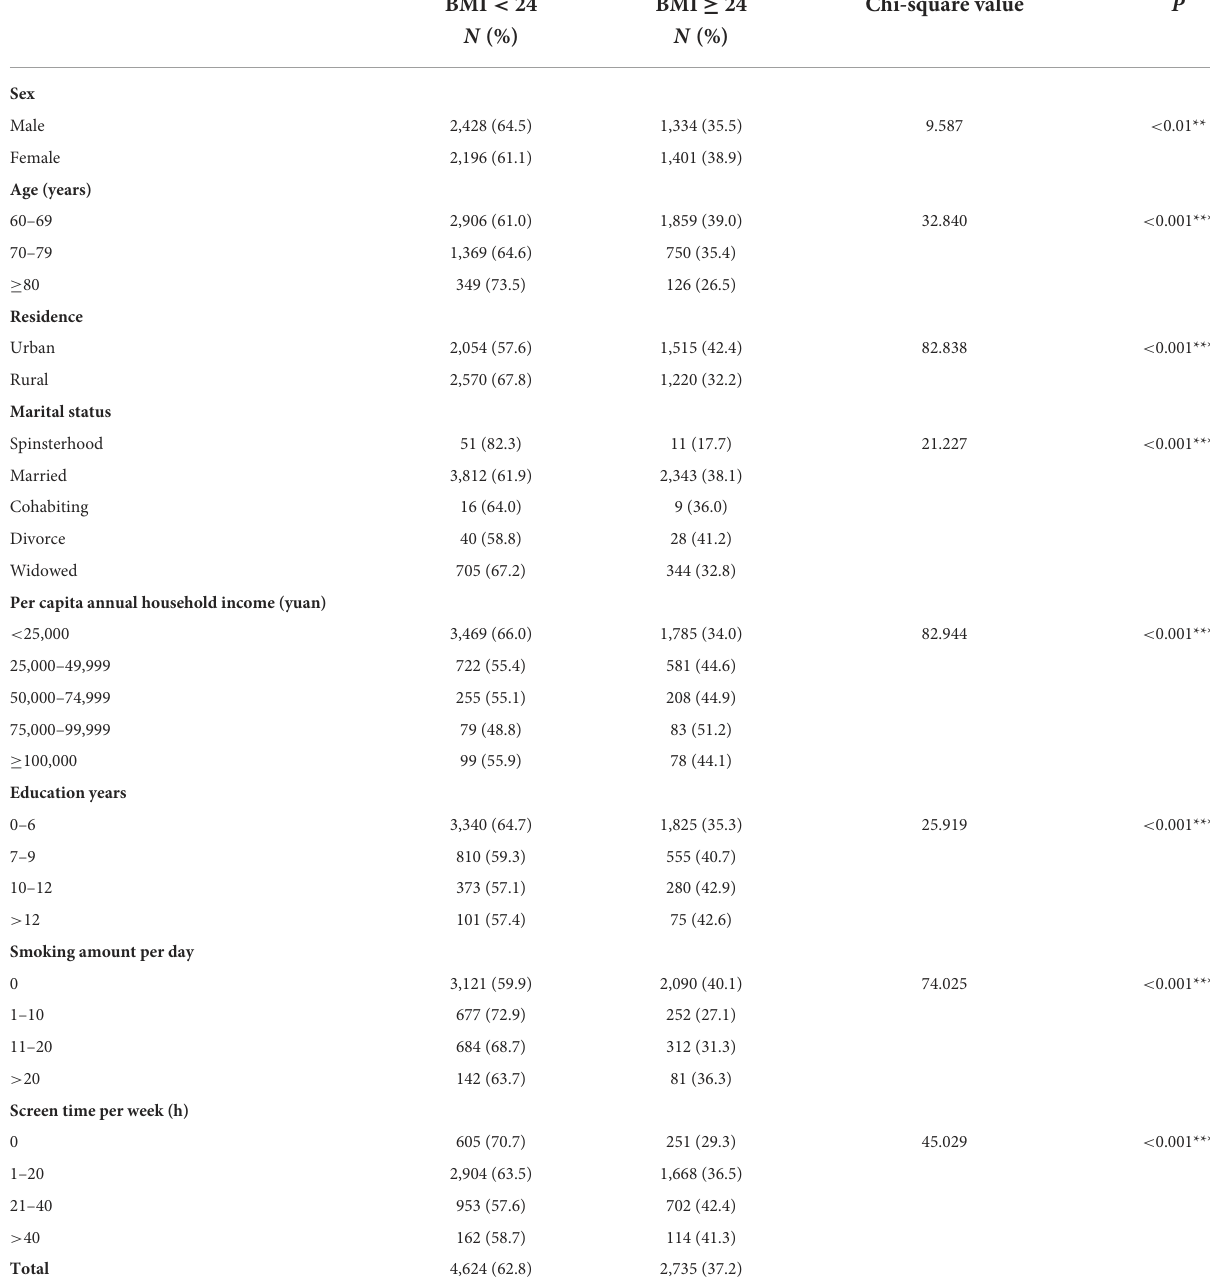
TABLE 1 BMI among older adults in China (comparisons were made with the chi-square test; n =